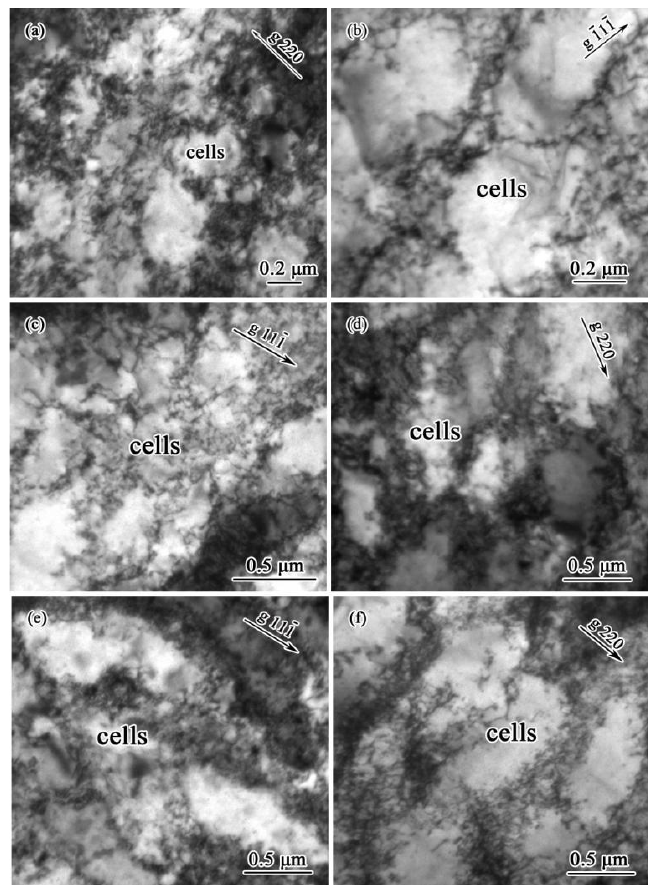
Figure 4. TEM images of dislocation configurations of unfatigued or pre-fatigued [ 233 ] Cu single crystals under uniaxial tension: ( a ) unfatigued, B = 113; pre-fatigued at ( b ) γ pl = 1.3 × 10 − 4 , B = 112; ( c ) γ pl = 3.4 × 10 − 4 , B = 011; ( d ) γ pl = 9.2 × 10 − 4 , B = 111; ( e ) γ pl = 3.5 × 10 − 3 , B = 011; and ( f ) γ pl = 5.3 × 10 − 3 , B =